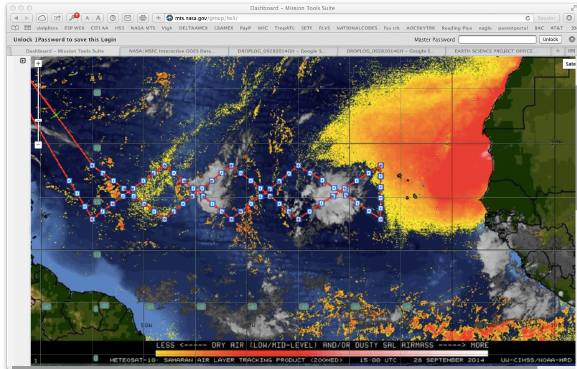
Figure 11. HS3 flight plan flight 4 for Hurricane Edouard